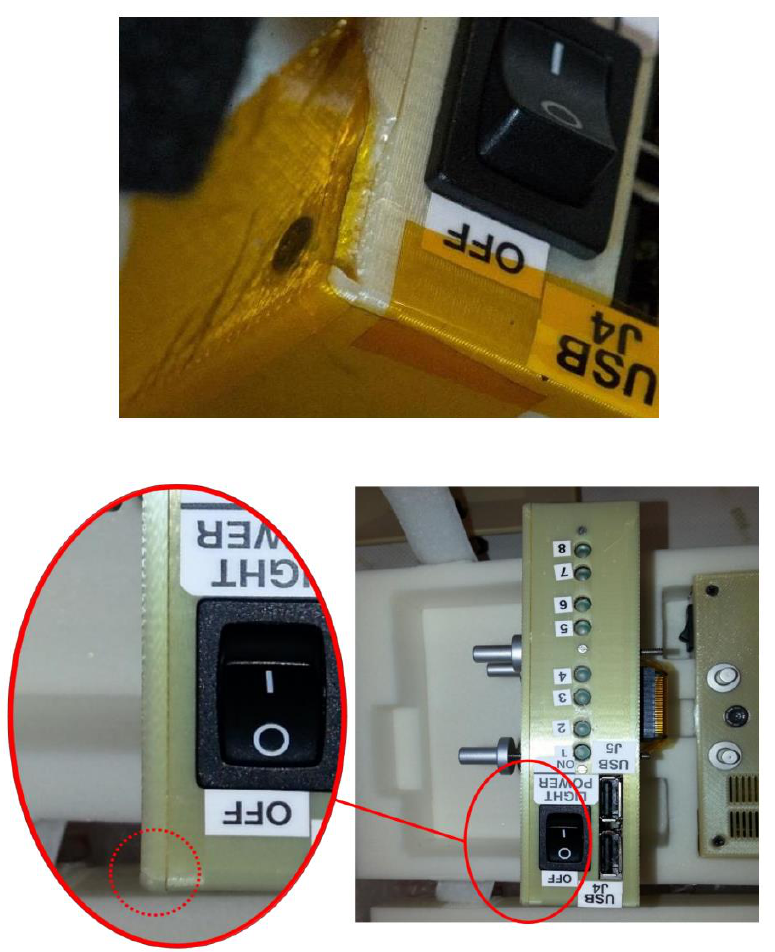
Figure 6. A broken 3D-printed part around the screw (top, onboard the ISS) and the same part during packaging for launch (bottom) [51]. Credit: NASA.